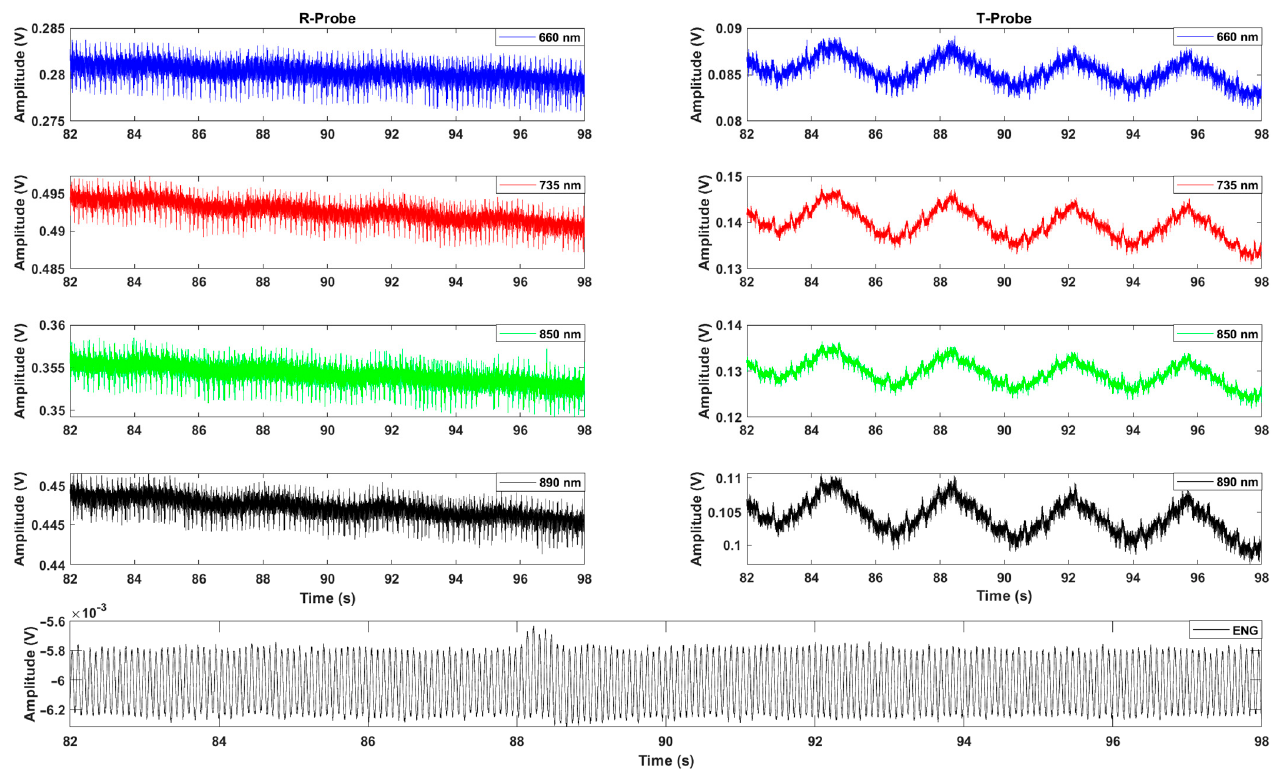
Figure 9. Temporal evolution of the raw PPG signals in baseline, obtained simultaneously with the reflection mode (R-probe) and the transmission mode (T-probe), for the four selected wavelengths and raw biopotential (s: second; V: volt).